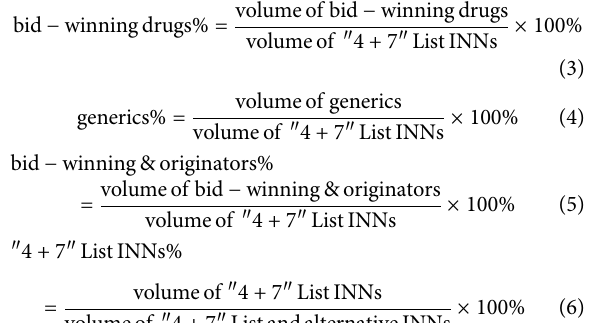
differences of outcome variables between the intervention group and the control group before and after policy implementation in period s , compared with the differences of outcome variables in the base period (assigned to the fi rst month of observation period). If the coef fi cient β pre statistical signi fi cance, it indicates a common trend of the corresponding outcome variable in intervention and control